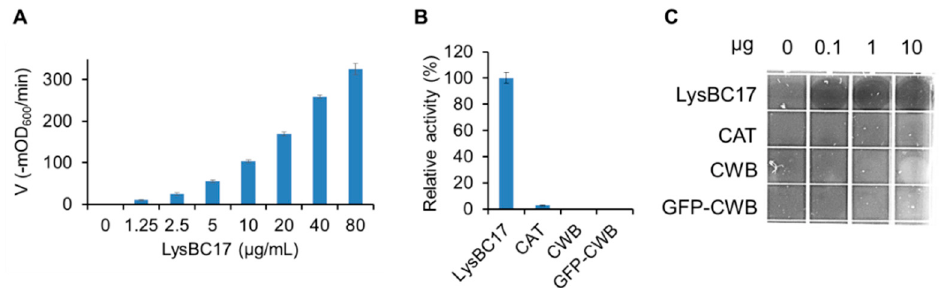
Figure 2. Lytic activity of LysBC17 and its derivatives. ( A ) Dose-response of LysBC17 activity by turbidity reduction assay (TRA). Activity velocity is measured as the drop in milli-optical density at λ 600 nm (-mOD 600 ) per minute. ( B ) Activity of full-length LysBC17 by TRA compared to its CAT, CWB, and a GFP-CWB fusion; each at 80 µg/mL. Experiments run, N = 3. Relative activity of 100% assigned to the maximum value in the data set. ( C ) Spot lysis assay of LysBC17 and its derivatives. B. cereus cells were embedded in BHI semisolid agar, and 10 µL of 0.01, 0.1, or 1.0 mg/mL endolysin or buffer control (“0”) were spotted on the top. The plate was incubated at 37 °C for 2 hours. Error bars represent the standard deviation.